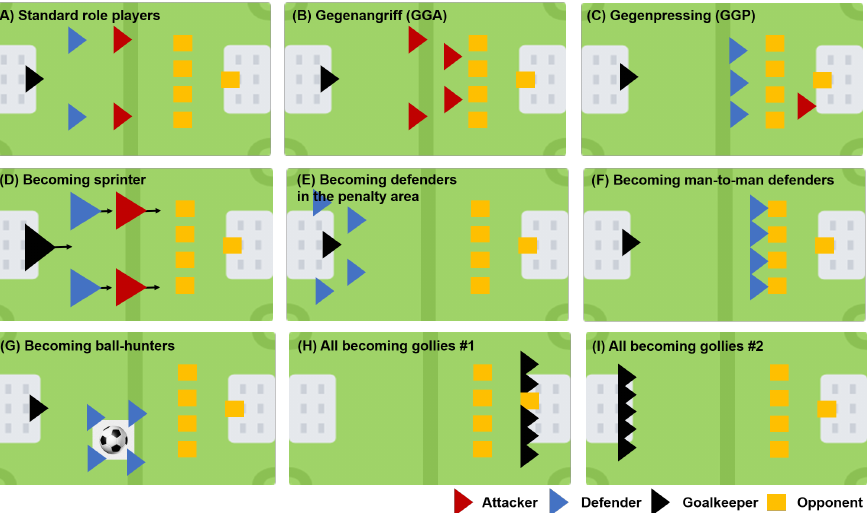
Figure 5. Nine sets of artificial football teams implemented by the dynamic planning